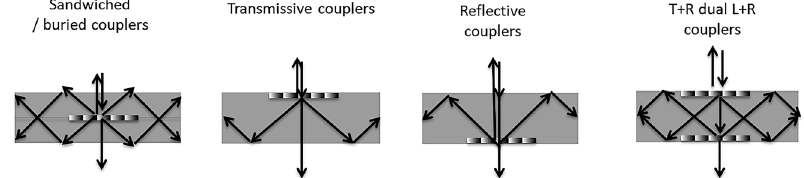
Figure 21: More functional coupler architectures that yield compact and efficient waveguide